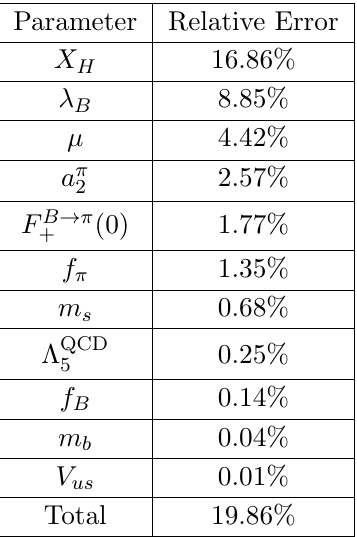
Table 2 . Error budget for the observable R (cid:25)(cid:25) . Here X H accounts for the endpoint singularities from hard scattering spectator interactions. F B ! (cid:25) B ! (cid:25) . The parameter (cid:21) B is the inverse moment of the LCDA of the B meson and a (cid:25) Gegenbauer moment for the (cid:25) meson.